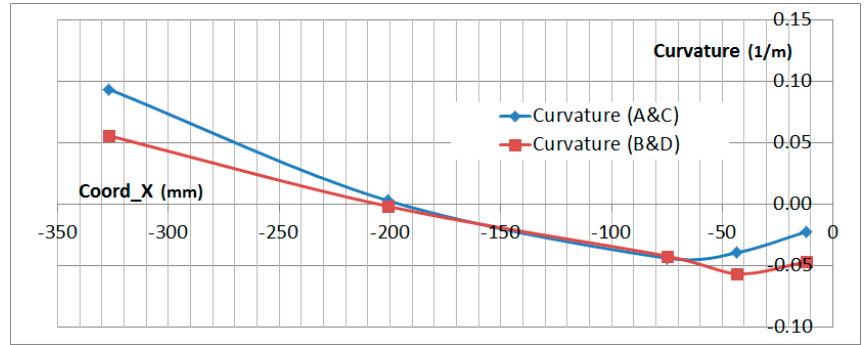
Figure 25. Calculated Curvature in Tension (650 kN).